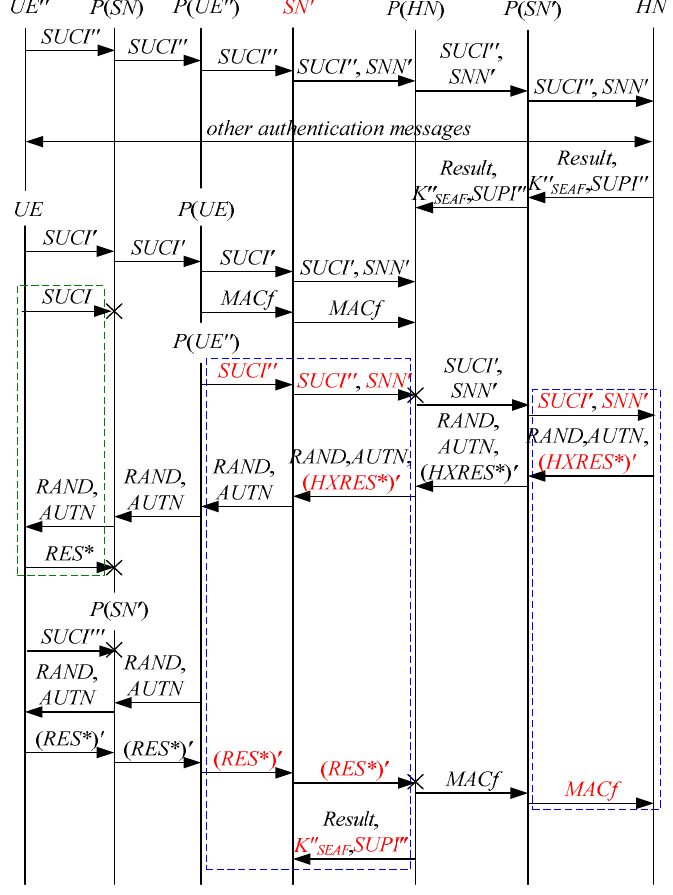
Figure 3. The second attack scenario of the 5G AKA protocol.